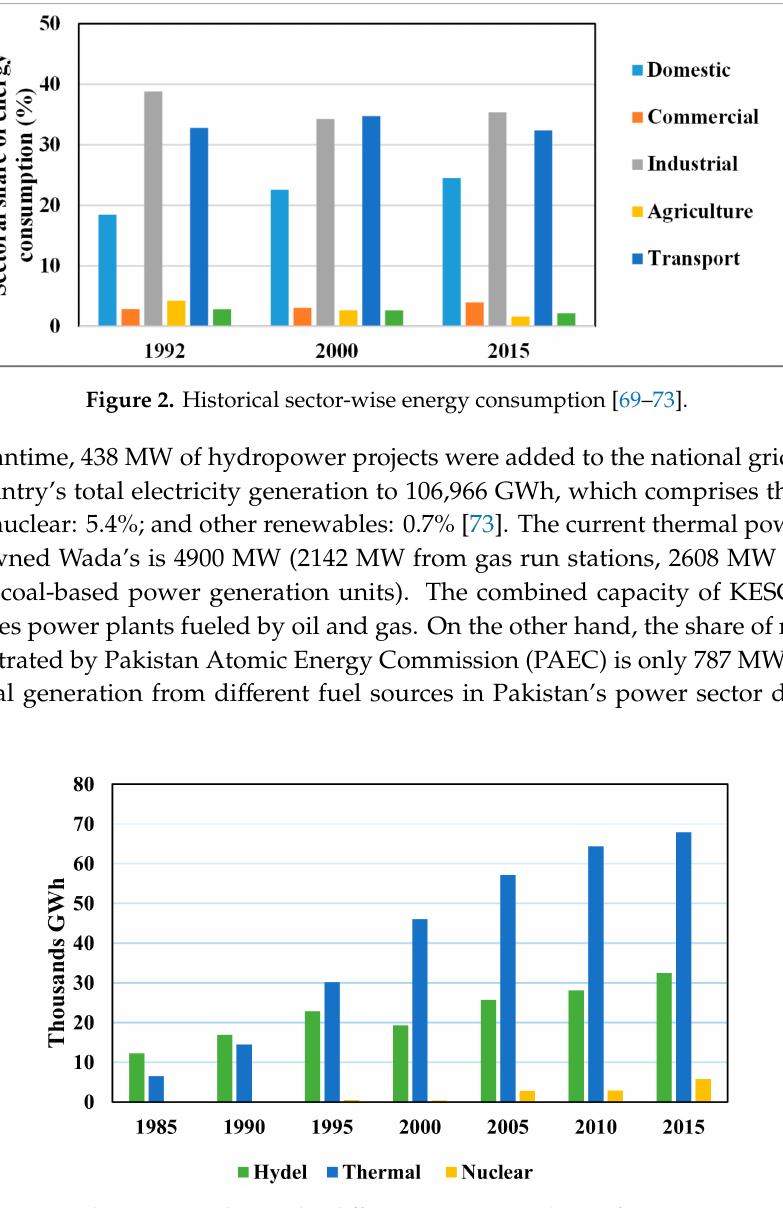
Figure 3. Electricity production by di ff erent sources in Pakistan from 1985 to